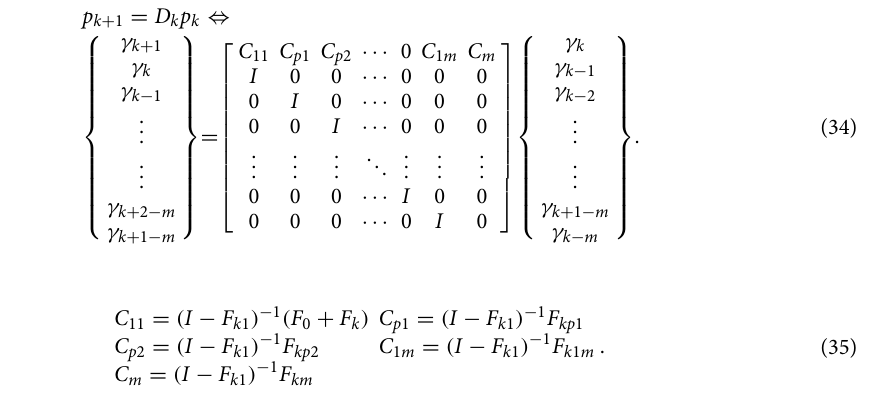
The Floquet transition matrix corresponding (cid:31) to the state-space expression of the cutting head can be expressed through the mapping function D k .